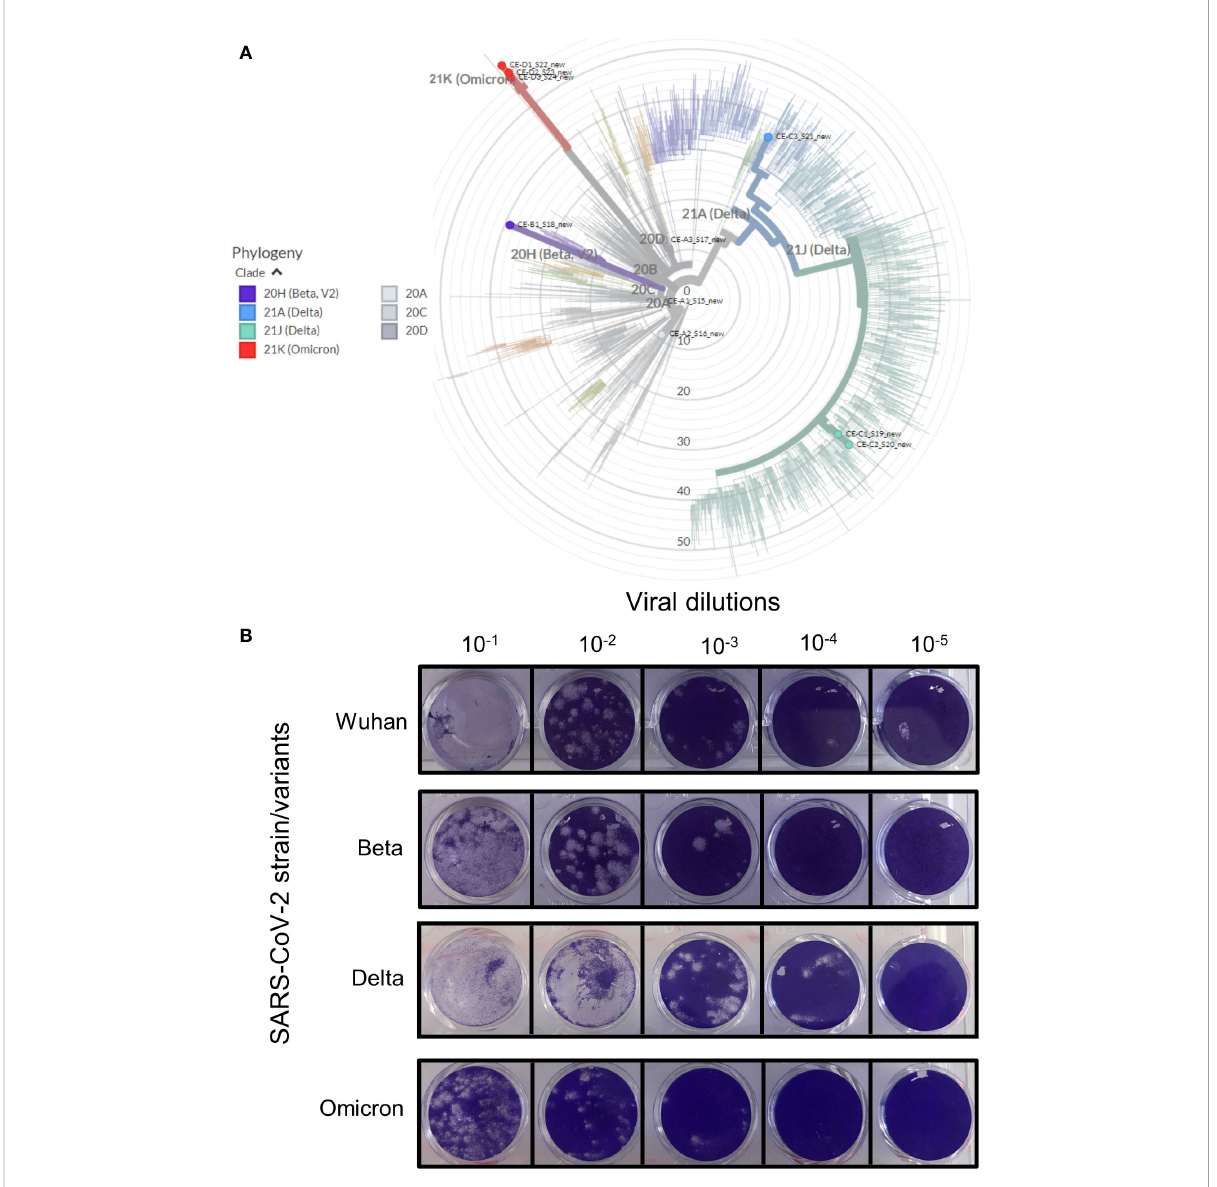
FIGURE 1 Veri fi cation of the various SARS-CoV-2 strains. Clinical patient samples were screened in Vero E6 cells to isolate the three SARS-CoV-2 variants. Strains were con fi rmed by qRT-PCR and positive samples were puri fi ed to generate stocks of each of the viral strains. (A) The genome of each strain was sequenced and the strain type con fi rmed using https://clades.nextstrain.org/. The phylogenetic tree classifying these isolates (coloured dots) relative to 2275 (auto-selected by the software) other genome sequences, were drawn using https://auspice.us/. Clades types shown by bold coloured line – wild-type (20A, C and D, grey), Beta (purple), Delta (blue and green) and Omicron (red). (B) Viability of isolate 1 (Figure S1) for each strain was tested using the Median Tissue Culture Infectious Dose (TCID) assay. Vero E6 cells seeded at 1 x 105 cells/ml were infected after 24 hrs with 10-fold dilutions of the respective viral strain. The cells were stained after 72 hours of incubation to assess for plaque formation as a measure of viral viability. All four strains were replication competent as shown by plaque formation in Vero E6 cell